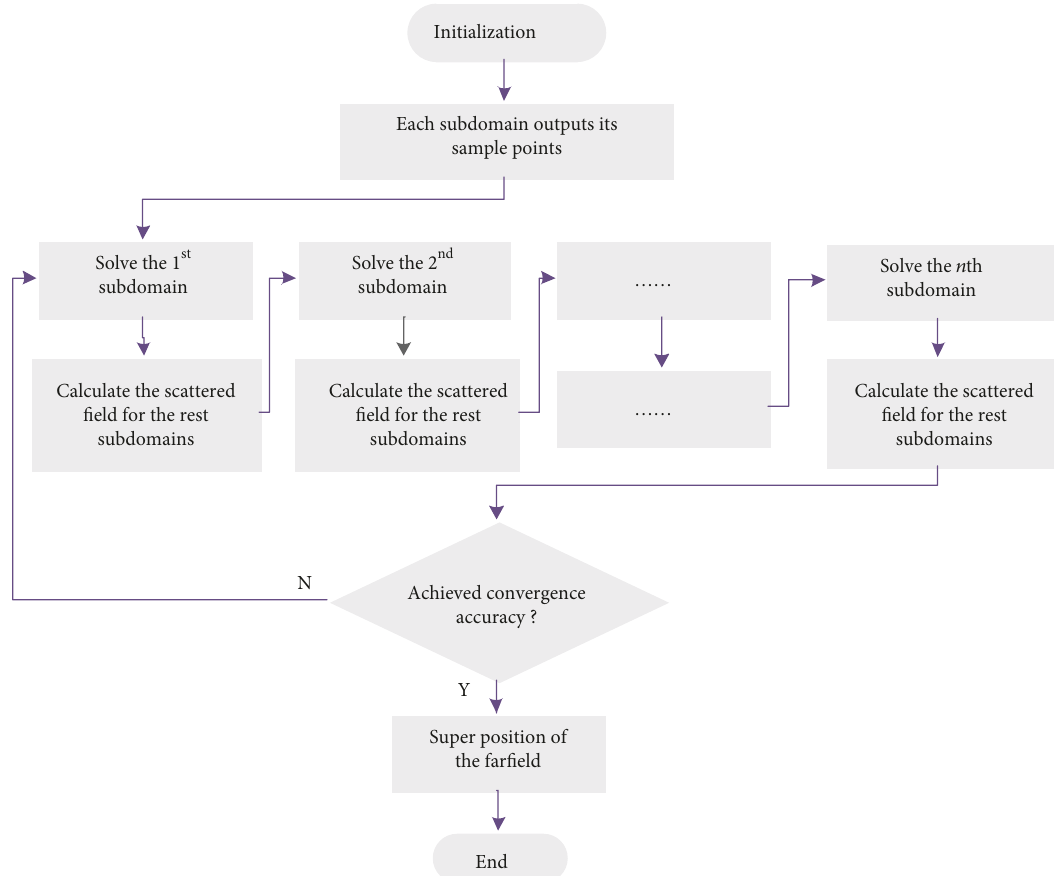
Figure 2: The fl owchart of the iterative